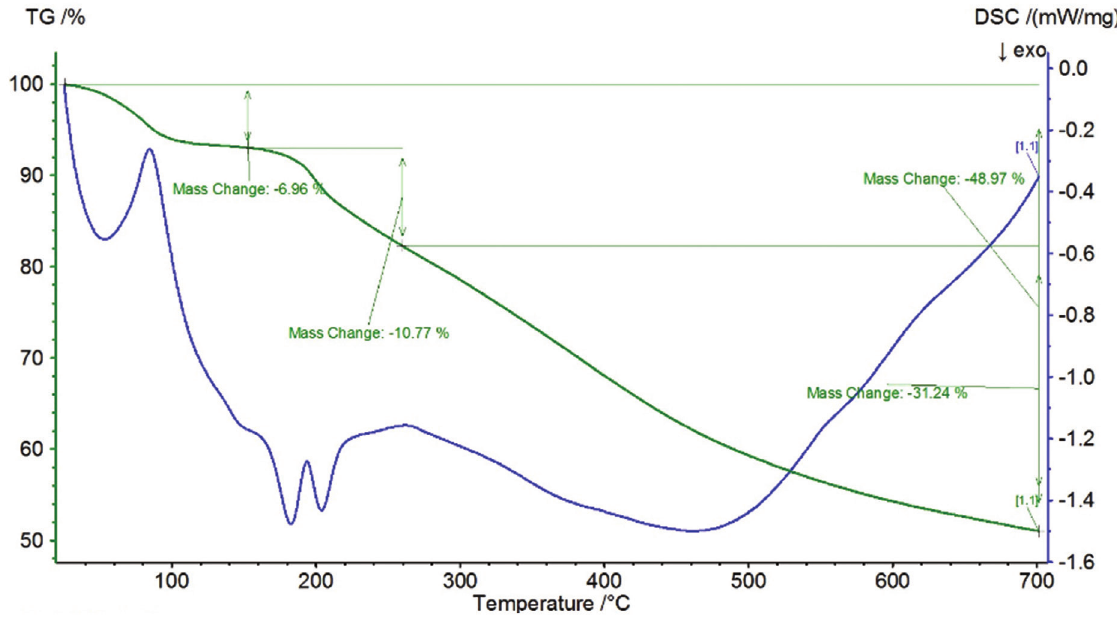
Figure 10: TG and DSC curves for 4-APAP thermal decomposition (heating rate